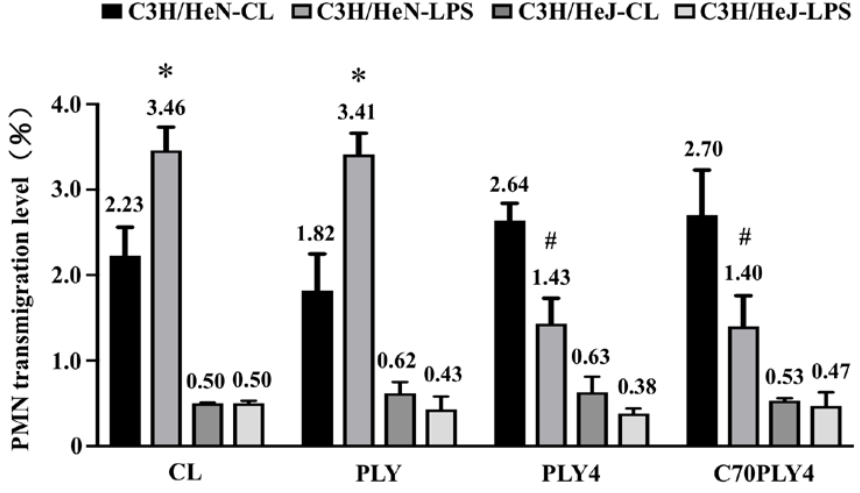
Figure 2. C70PLY4 targets TLR4 to inhibit the LPS-activated transendothelial migration of PMNs isolated from TLR4-wild-type mice. PMNs were isolated from C3H/HeN (TLR4-wild-type) and C3H/HeJ (TLR4-deficient) mice. The isolated PMNs were treated with PBS to serve as a control or with various PLY fragments, including PLY, PLY4, and C70PLY4, and then the isolated PMNs were added to the Transwell upper chamber cultured with HUVECs. LPS (1 μg/mL) was added to